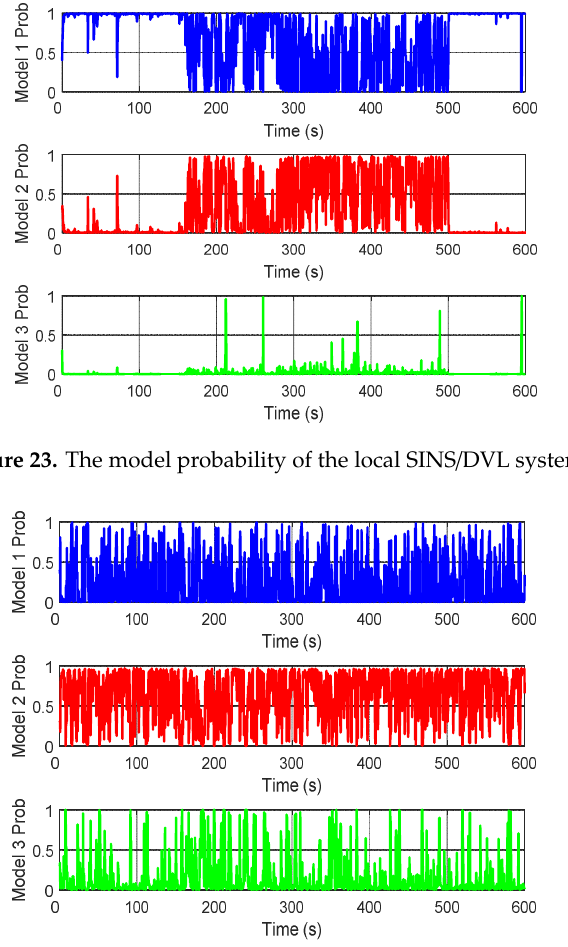
Figure 24. The model probability of the local SINS / TAN system.